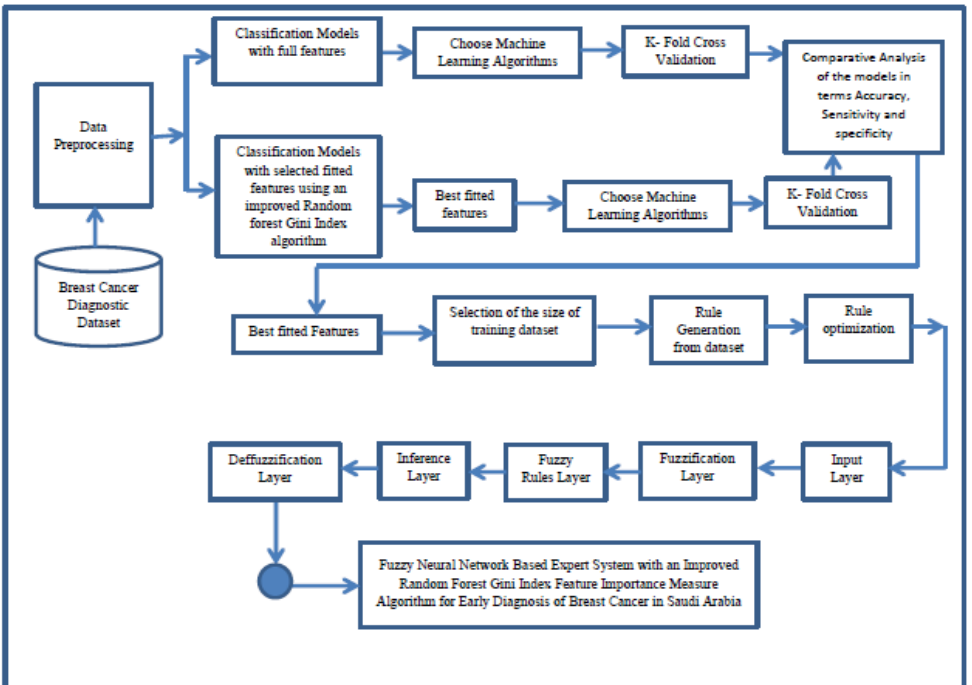
Figure 1. Research methodology.